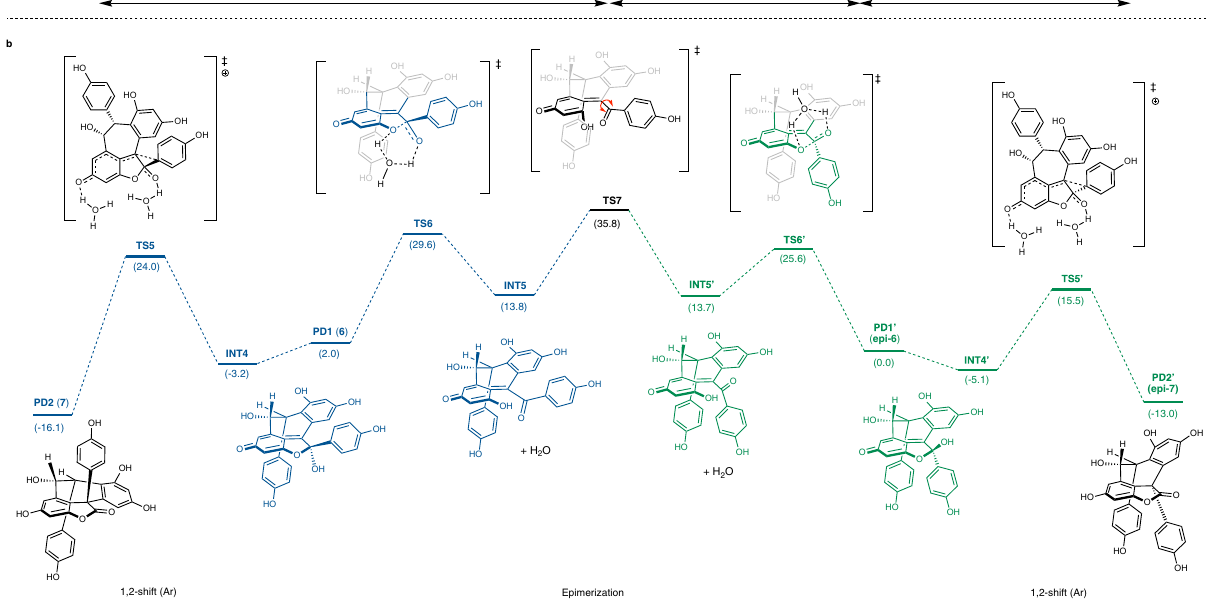
Fig. 2 DFT calculation of biosynthetic pathway of vaticahainol A and B. a Energy diagram for the biosynthesis of vaticahainol B ( 6 ) and its epimer ( epi-6 ). b Energy diagram for the biosynthesis of vaticahainol A ( 7 ) and its epimer ( epi-7 ). SM starting material, CP complex, TS transition state, INT intermediate, PD